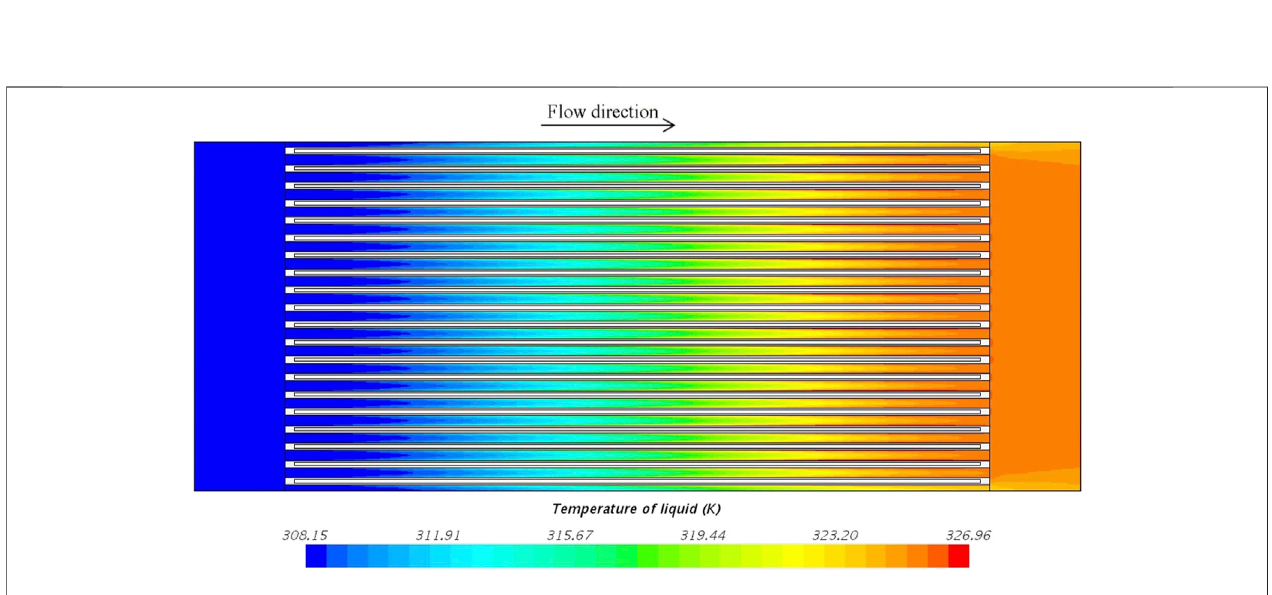
FIGURE 6 | Temperature distribution of the coolant (scale: x : z (cid:1) 1:5).